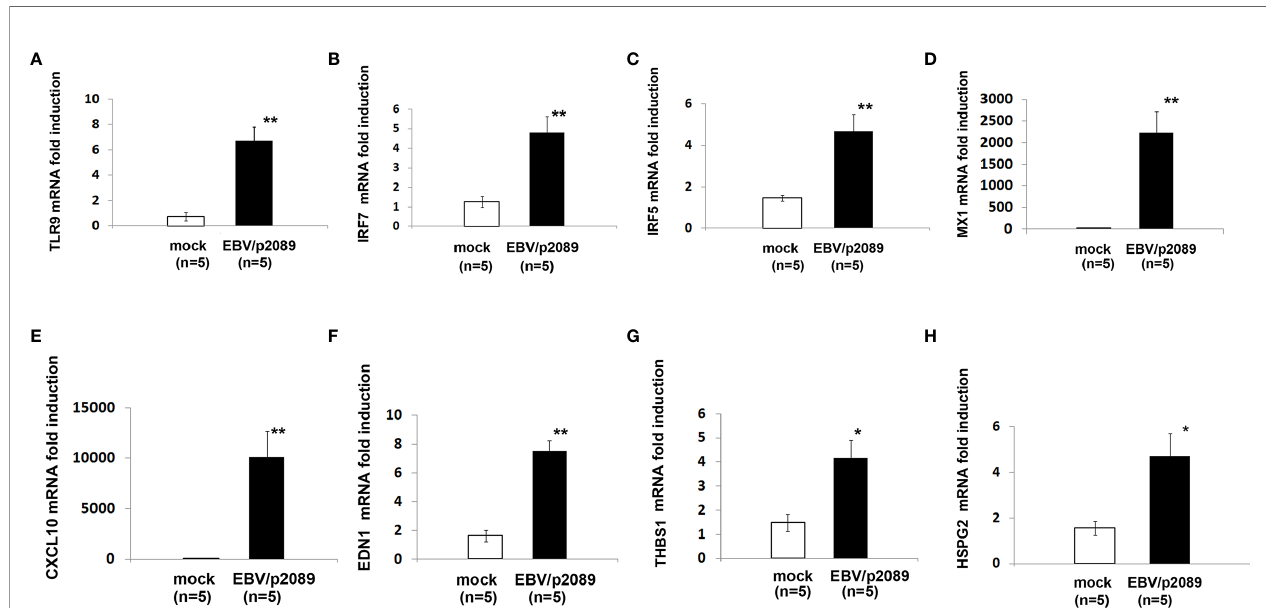
FIGURE 7 | EBV activates innate antiviral response and markers of vascular injury in infected endothelial cells. Monocytes from healthy donors (HDs) bound to EBV- p2089 were co-cultured with human dermal microvascular endothelial cells (HDMECs). Monocytes not exposed to EBV-p2089 were co-cultured with HDMECs as mock- infection. After 42h monocytes EBV-p2089 cell-free virus were removed from endothelial cell cultures and total RNA extracted after. (A – H) mRNA expression of indicated genes in EBVp2089-infected and mock-infected endothelial cells, evaluated by qPCR. Fold-changes shown on the graph are normalized to mRNA expression by one mock infected cell line. Bars represent mean ± S.E.M. from 5 separate endothelial cell lines. p-values calculated using two-tailed T-test. *p<0.05,